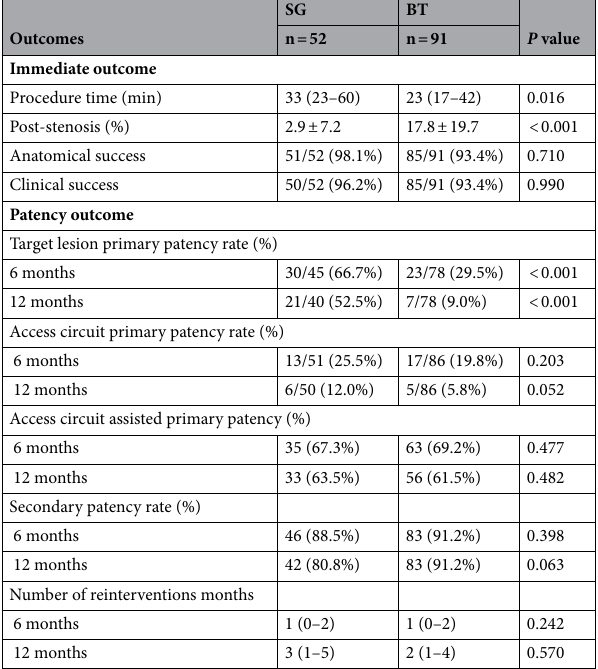
Table 2. Comparison of immediate and patency outcomes. Data are presented as n (%), median (IQR), or mean ± SD. SG stent graft, BT balloon